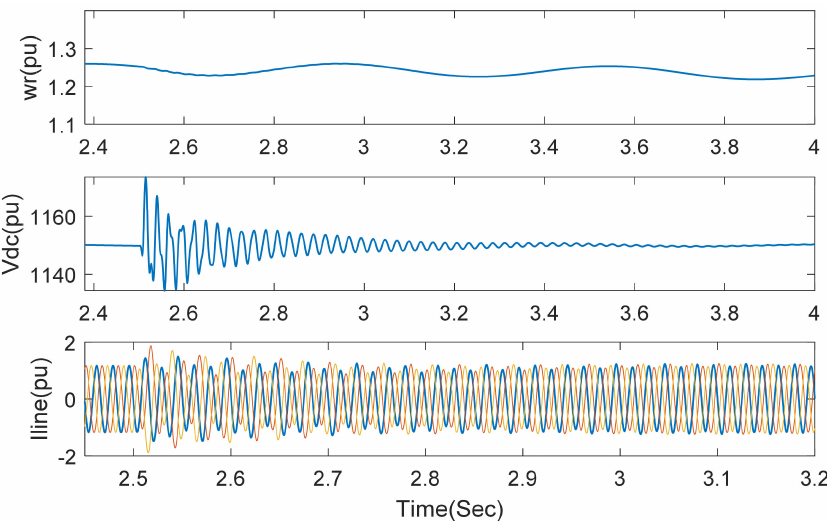
Figure 6. Transient responses of rotor angular speed, DC bus voltage, and transmission line current after 85% series compensation is